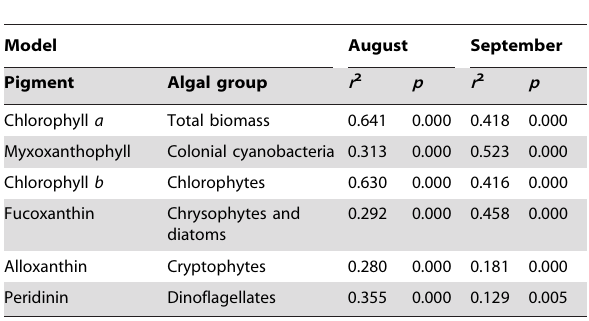
Table 3. Least-squares regression analysis of the linear relationship between microscopic and chromatographic estimates of phytoplankton